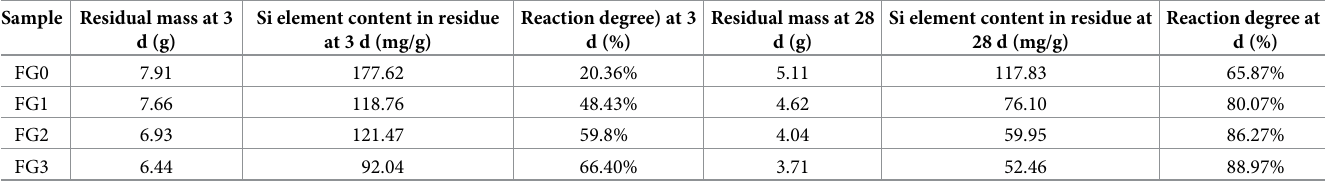
Table 5. Quantification of the degree of geopolymer reaction in each group. Sample Residual mass at 3 d